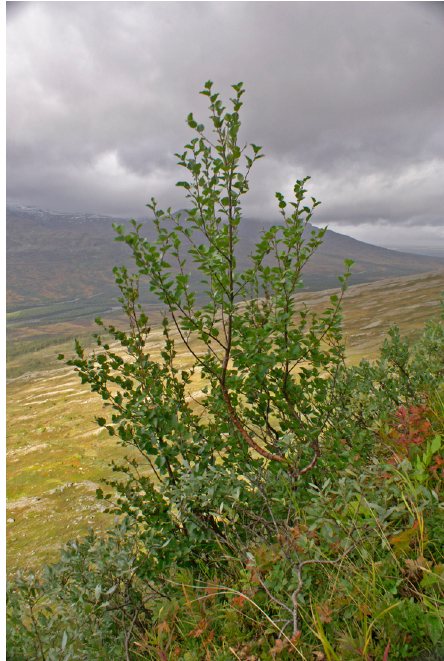
Figure 3: Young and rapidly growing birch, constituting the recently elevated treeline, 1010 m a.s.l., at the site depicted in Figure